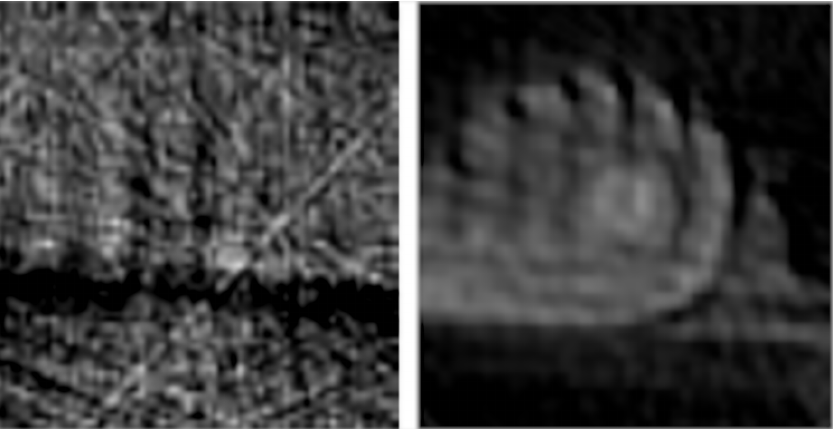
Figure 5. Left : Fingers model scanned using only water; Right : As damped step functions were now present in the signal due to the Xanthan gum, they could be used as an AC signal to the lock-in amplifier; the image is much